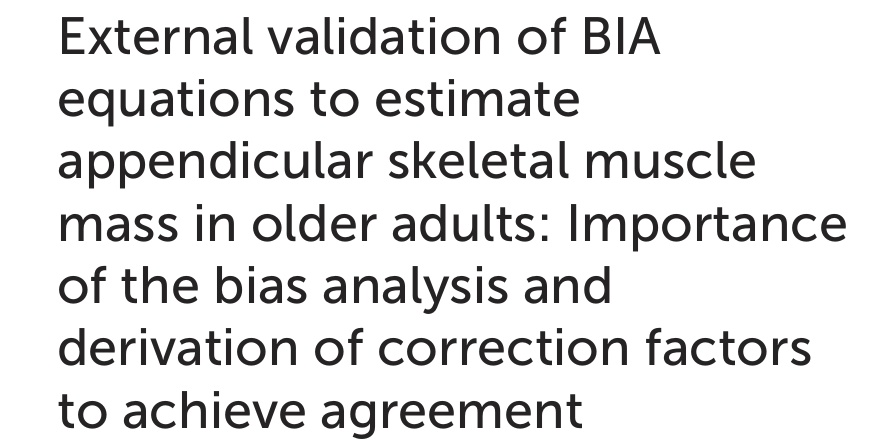
validation of BIA equations to estimate appendicular skeletal muscle mass in